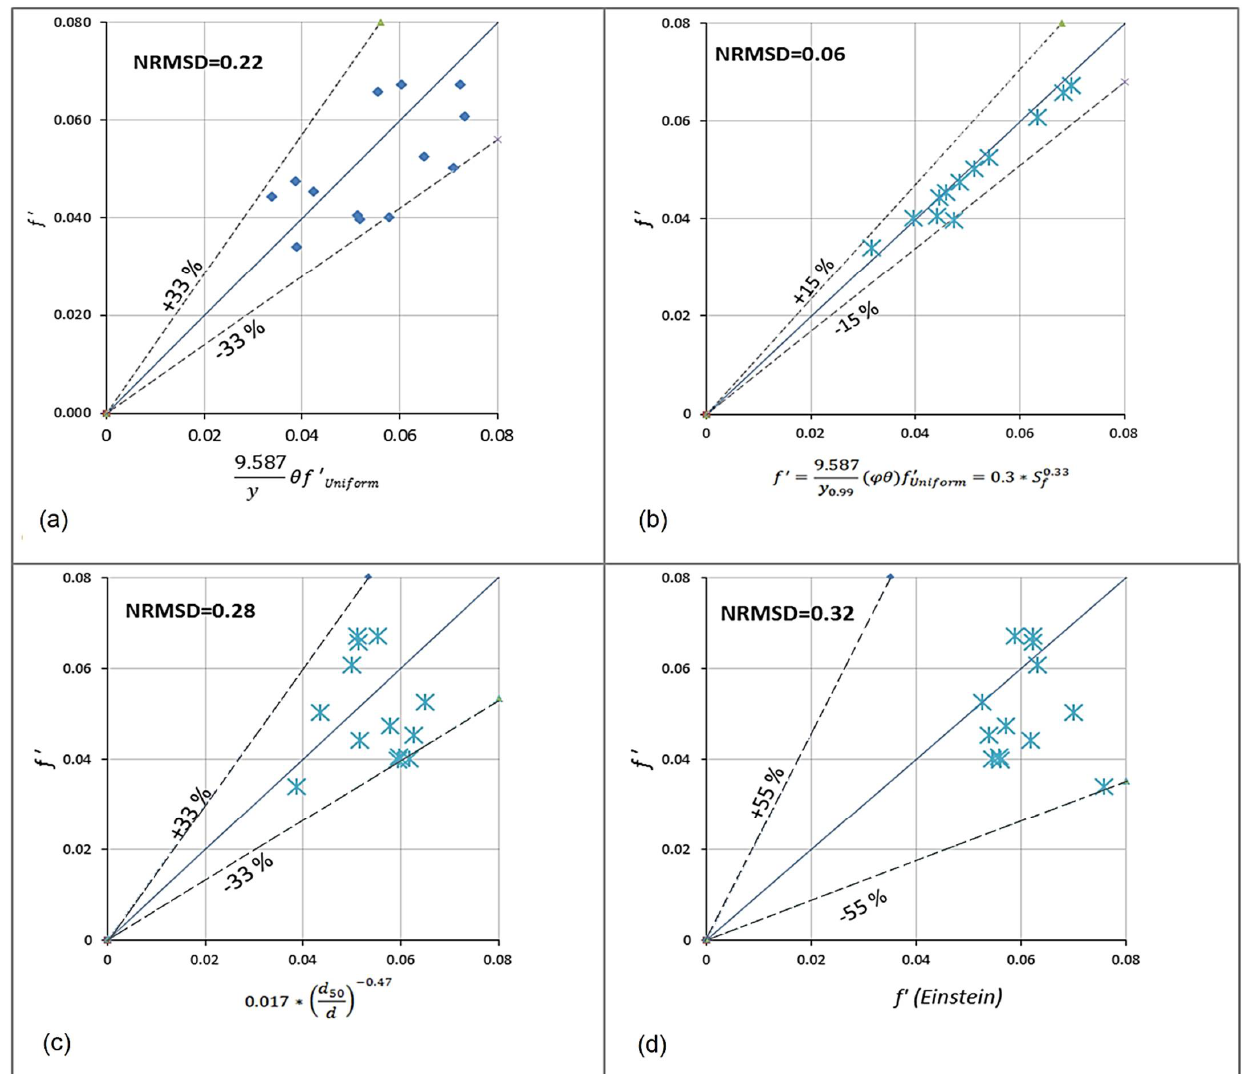
Figure 7. Skin friction factor calculated using Equation (20) ( a ), Equation (21) ( b ), modified Einstein–Strickler Equation ( c ), and classic Einstein–Strickler Equation ( d ), in the Marbor River. The vertical axis shows the skin friction factor calculated with the flow characteristic method. The ranges of deviations are shown with dashed blue lines.